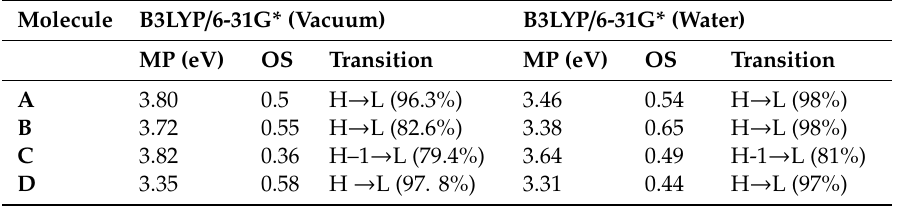
Figure 8. Absorption spectra of coumarin derivatives in vacuum (black) and solvent (red) calculated with B3LYP/6-31G* model. Table 6. Main absorption peak energy value, oscillator strength (OS) and their associated electronic excitations transition for the vacuum and solvent model systems, are included here. The transition weight is reported in %, and H stands for HOMO and L for